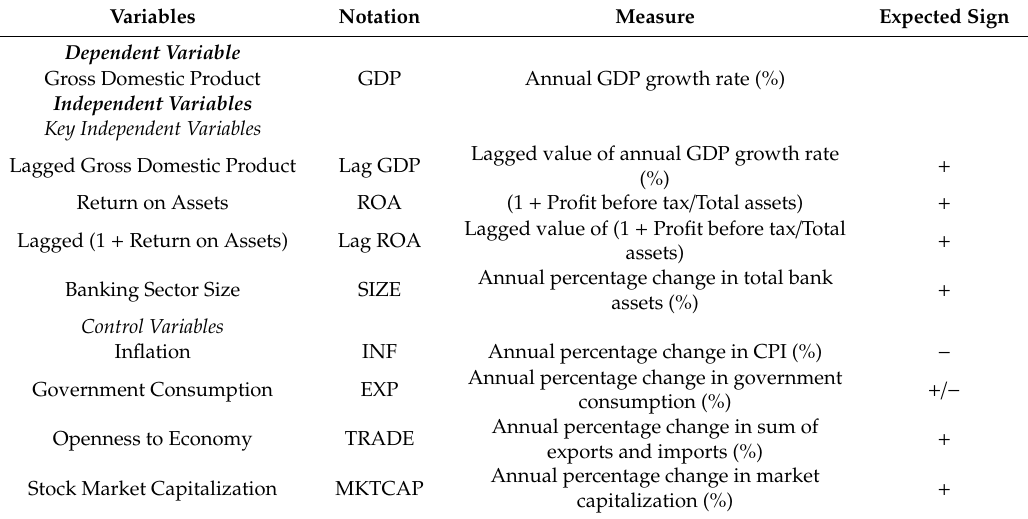
Table 4. Definition, notation, and expected e ff ect of the variables.